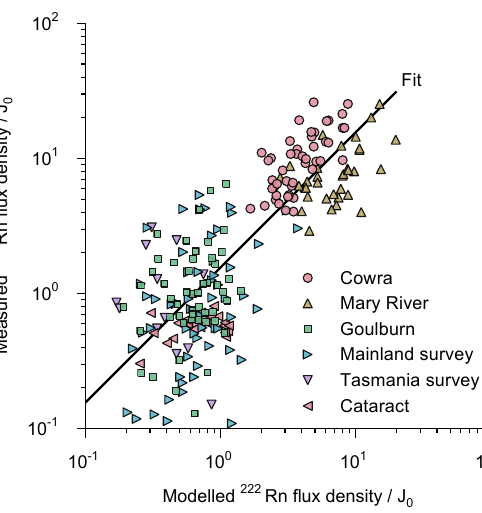
Fig. 6. Correlation between modelled and measured radon flux density, J 0 = 22mBqm − 2 s − 1 . The line of best fit is y = 1 . 6 x with R 2 = 0 . 48. Repeat measurements are grouped together: Cowra data are from Feb and Jul 2008; Mary River from September 2008; Goulburn from August 2006 and February 2008; Mainland from June 1986; Tasmanian from February and August 1996 and De- cember 1997; and Cataract data from January–December 1998. The Cataract points shown are the average across all Cataract sites for each of the measurement days and are not included in the fit.